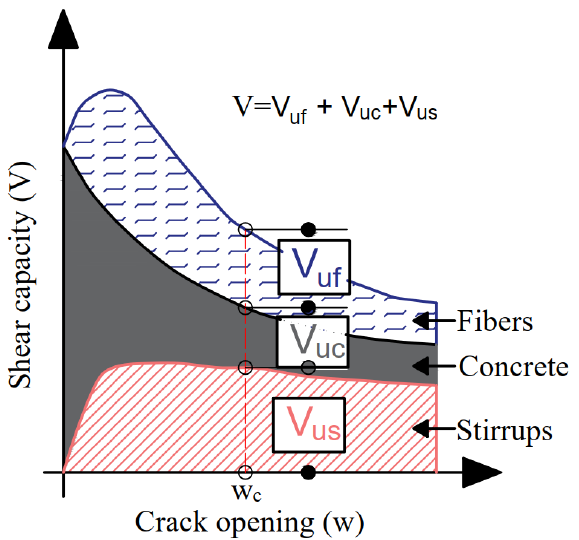
Figure 3. The interrelationship between concrete matrix, fibers, and reinforcement components in the determination of shear capacity [37]. V uf = fibers contribution, V uc = Concrete matrix contribution, V us = Stirrups Contribution.